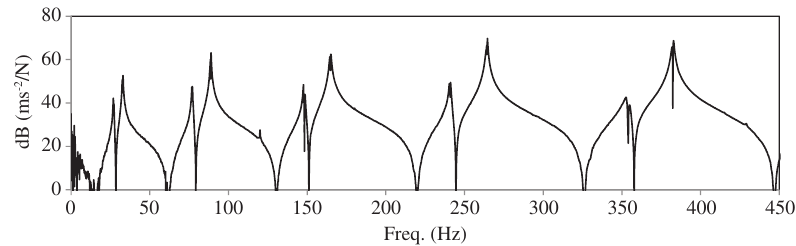
for truncated cone # 1. 11